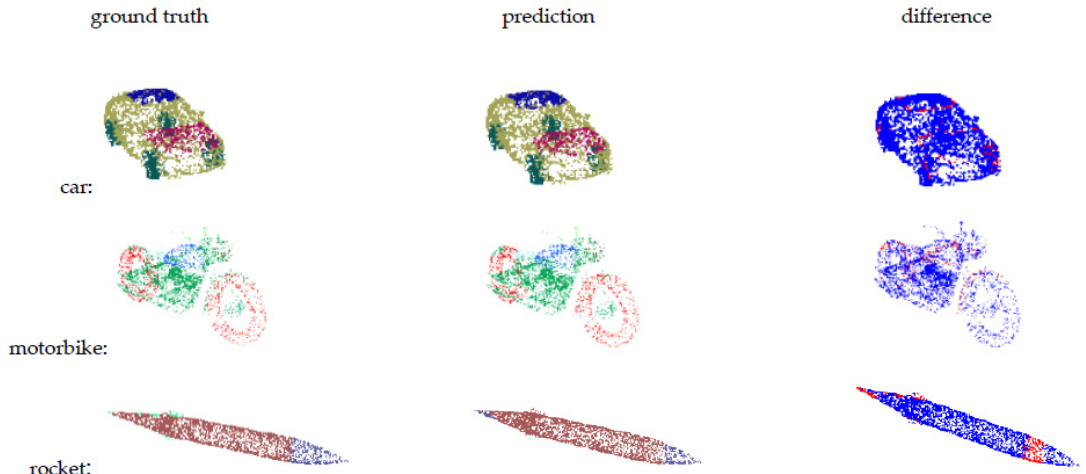
11 Table 2. Segmentation results on the ShapeNet Parts dataset [6]. PointNet [11]